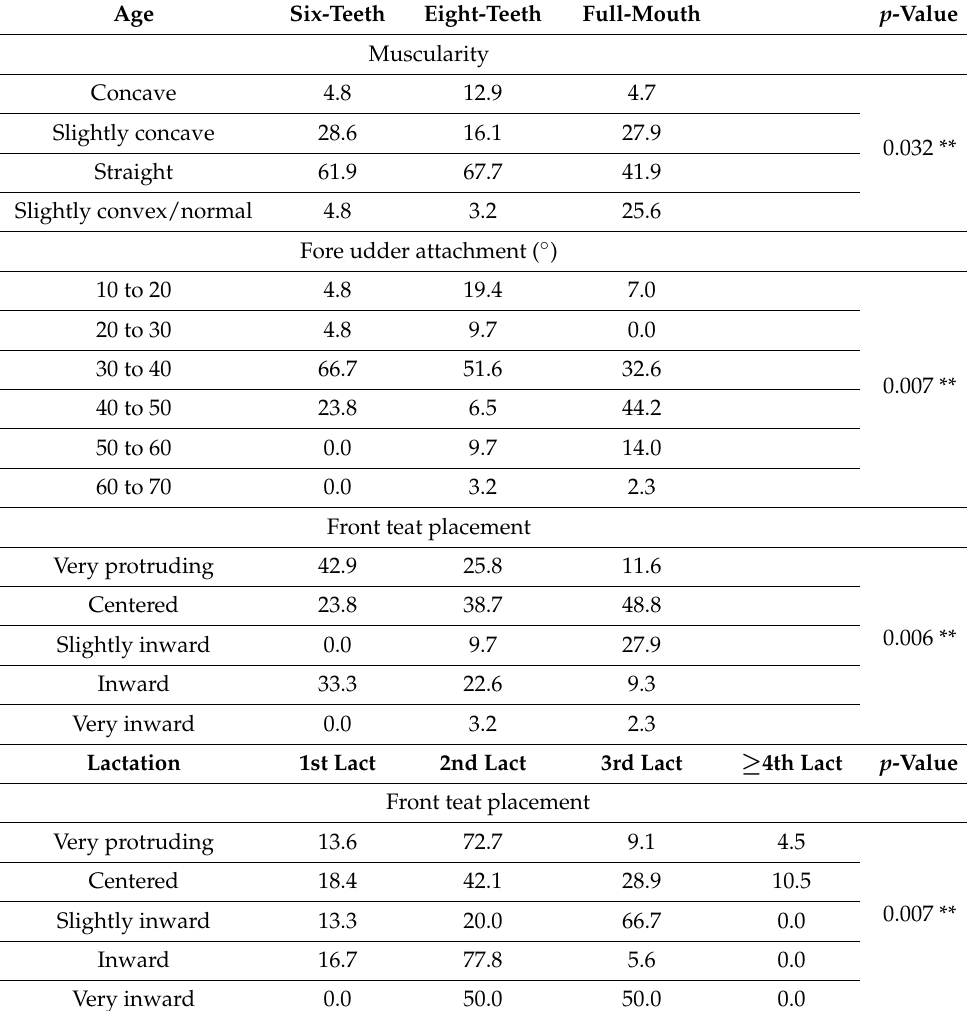
Table 6. Significant qualitative traits of Creole cows (N = 95) according to age and lactation (%) 1 . Age